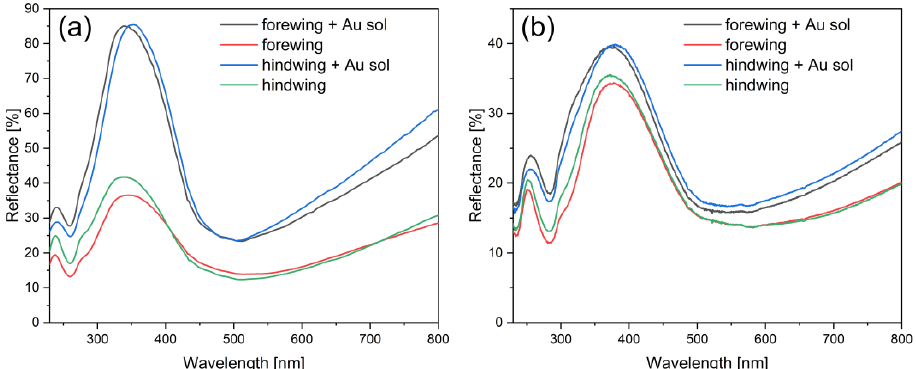
Figure 3. Reflectance measured on the wings of a male Polyommatus icarus butterfly before and after the drop-drying of sodium citrate-based Au NP sol. ( a ) Measurement in normal incidence: red and green curves show the pristine status, and the black and blue curves were taken after the complete drying; ( b ) measurement with an integrating sphere: red and green curves show the pristine status, and the black and blue curves were taken after the complete drying.